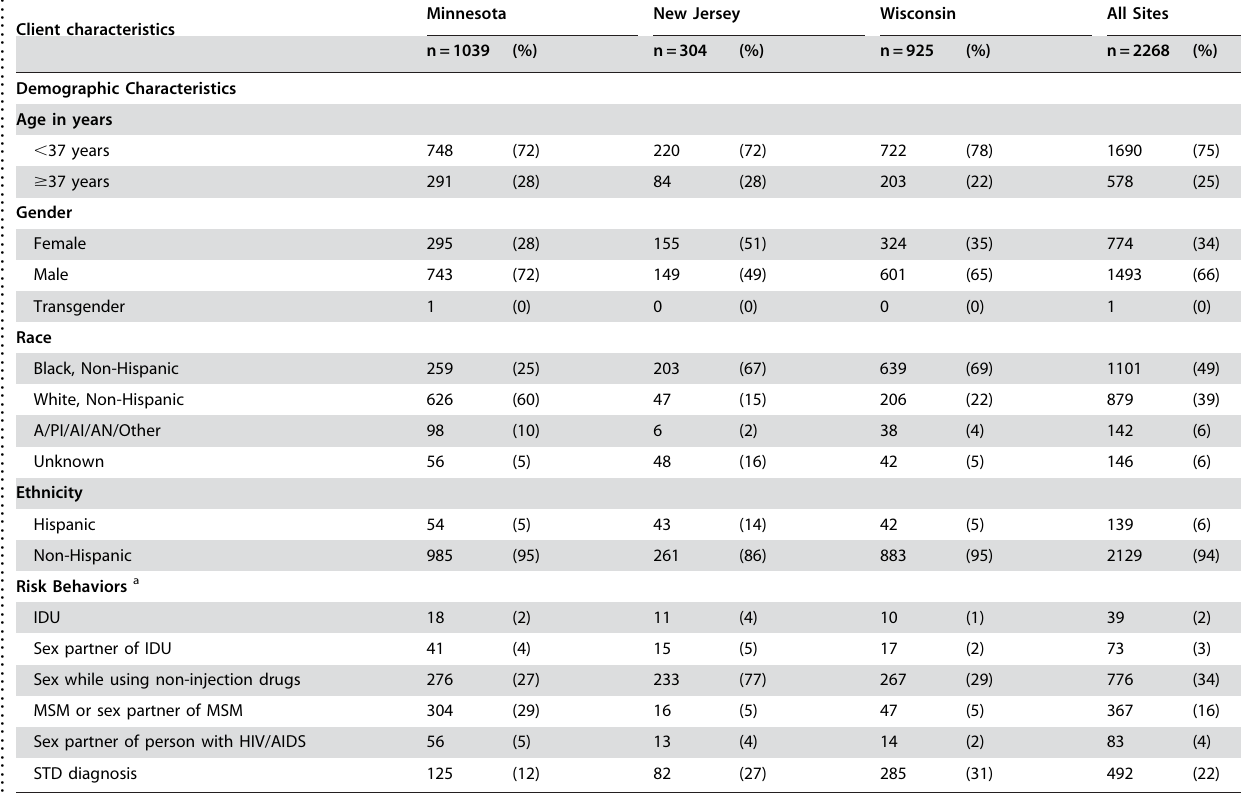
Table 2. Demographic characteristics and HIV risk behaviors of 2268 clients whose finger-stick whole blood and oral fluid specimens were tested with the OraQuick Advance rapid HIV test, by state—incidence study, February 2005 through May 2005. .. ... .... ... ... .... ... ... .... ... ... .... ... ... .... ... ... .... ... ... .... ... ... .... ... ... .... ... ... .... ... ... .... ... ... .... ... ... .... ... ... .... ... ... .